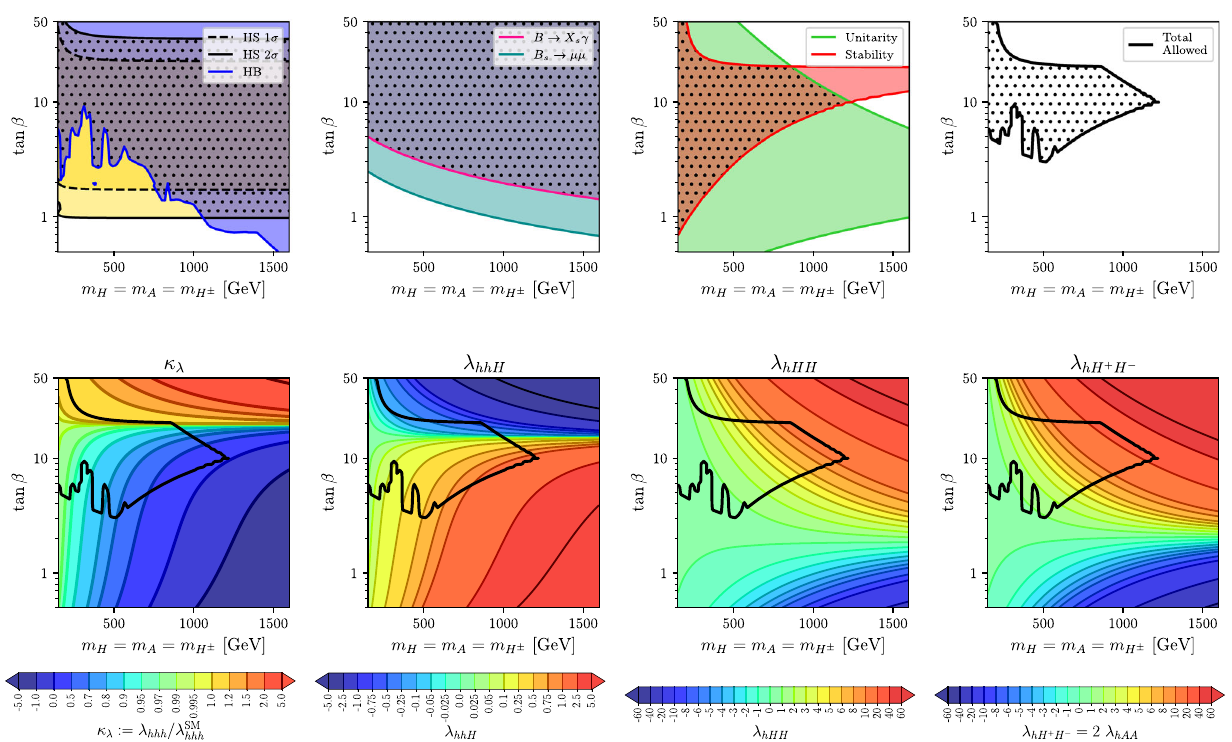
Fig. 7 Allowed areas (dotted regions) from the various constraints (upper row) and triple Higgs couplings (lower row) for the benchmark scenario I-4 in the m –tan β plane with c β − α = 0 . 2 and m 2 fixed via Eq. 12